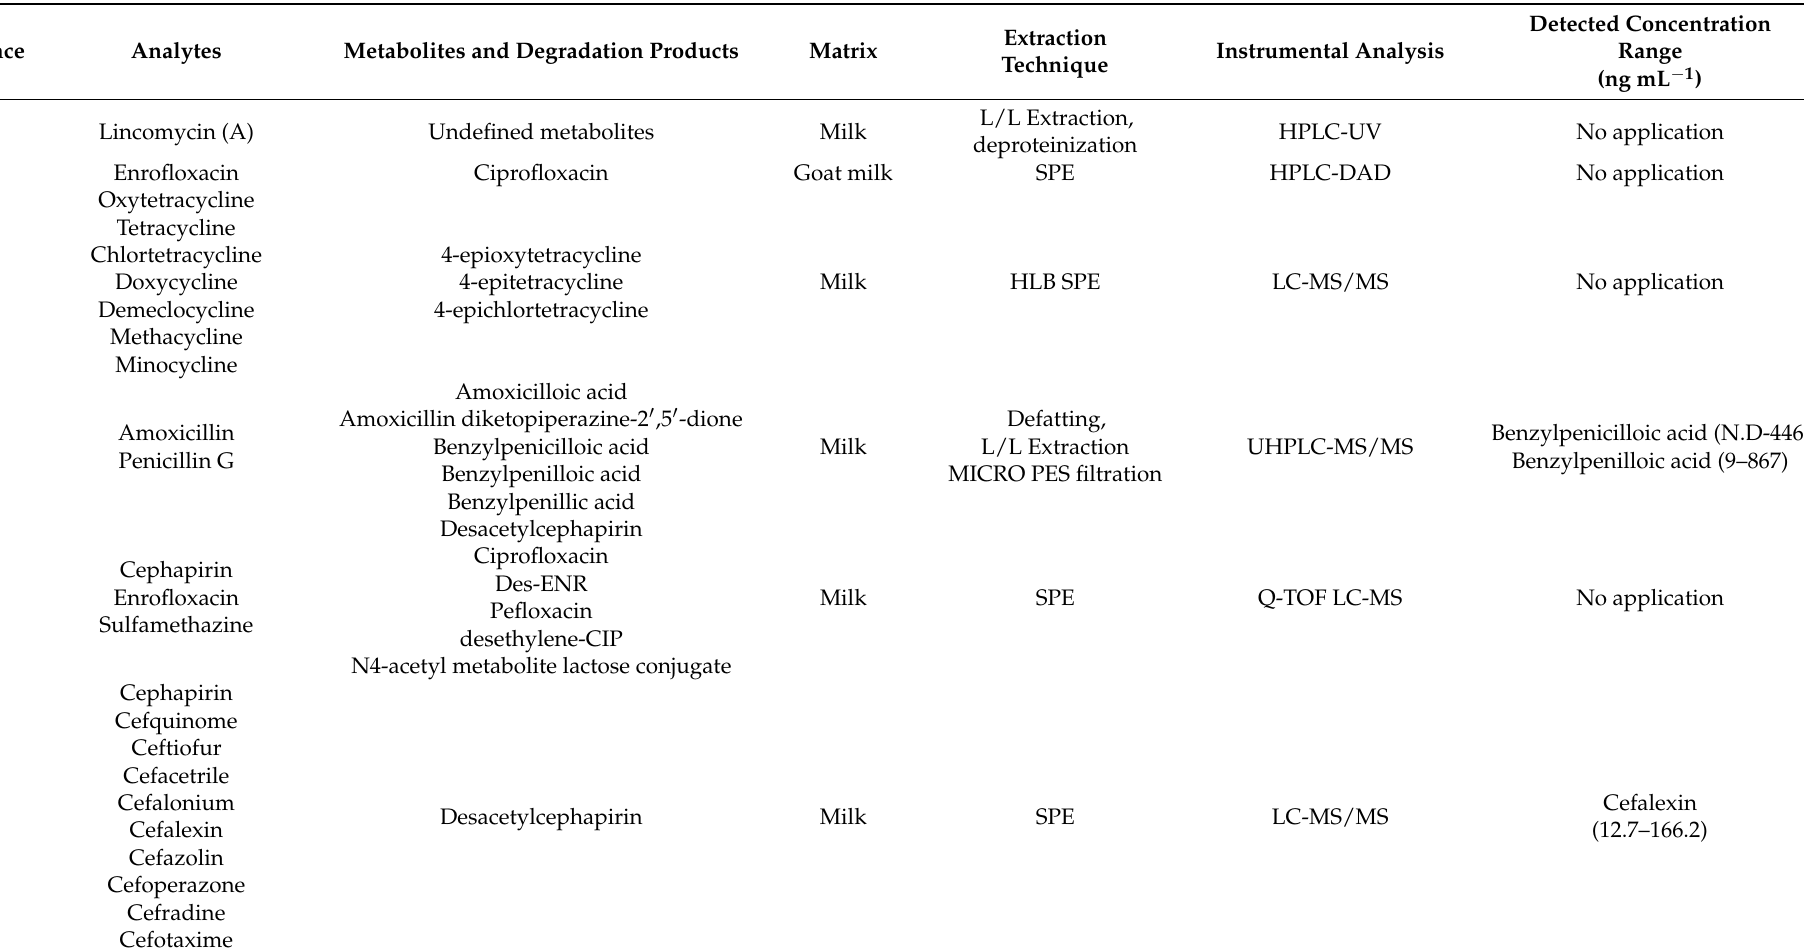
Table 1. State of the art regarding antimicrobial metabolites and degradation products in